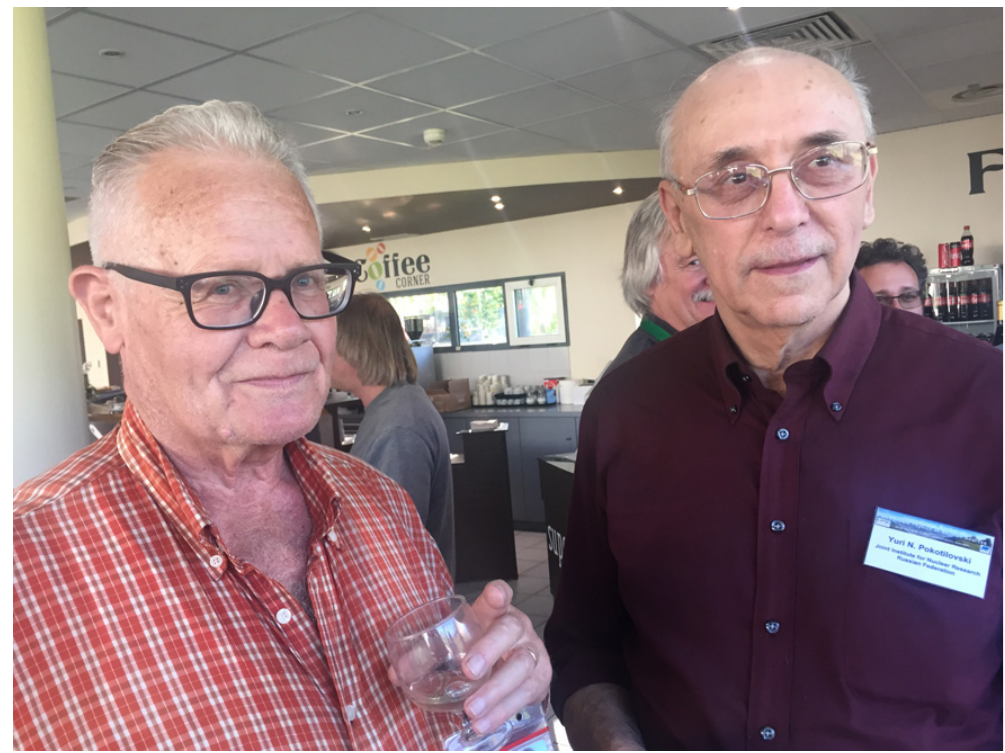
Figure 1. This photograph taken at the PPNS workshop in May 2018 shows Yuri N. Pokotilovskii, member of the Dubna team (right) and Albert Steyerl (left), two of the pioneers of research with ultra-cold neutrons. Table 1. Ultra-cold neutrons can be trapped by the optical potential of matter, by local gravity g , or by magnetic